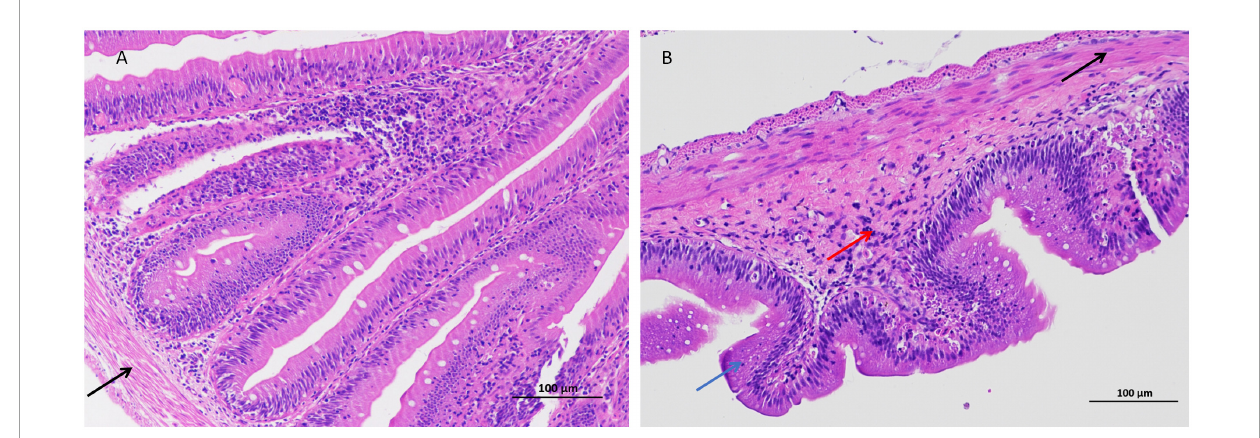
FIGURE1 Arsenic caused distal intestinal histopathological changes (200 × magnification). (A) Control group, (B) arsenic (As)-treated group. Blue arrows ( Ű ): shortened intestinal villi, right black arrow ( Ű ): thinner muscular layer, and red arrows ( Ű ): inflammatory cell